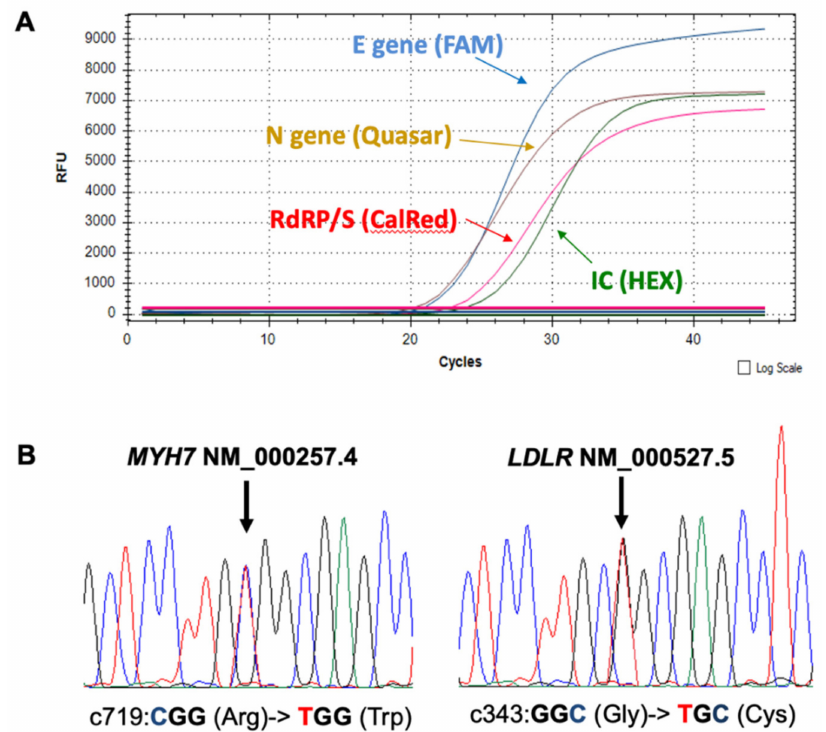
Figure 2. ( A ) Real time PCR (RT-PCR) shows the positivity of the proband for all the three SARS-CoV- 2 genes (threshold cycle values below 25). RFU = relative fluorescent units. ( B ) Electropherograms show the identification of a heterozygous genetic variant in the MYH7 (p.Arg719Trp) gene and